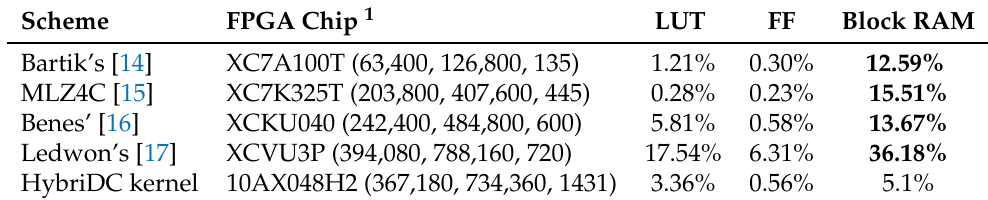
Table 1. Utilization proportions of various resources in different compression accelerators. The consumption proportion of the block RAM is significantly larger than those of other resources in most